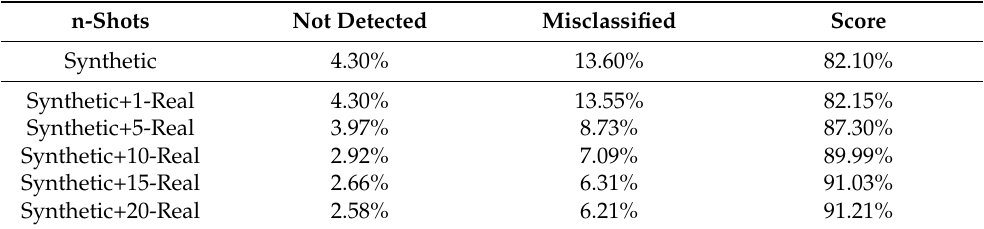
Table 6. Application-oriented metric results comparing {3} with few-shot fine-tuning against the uncontrolled dataset {4} .